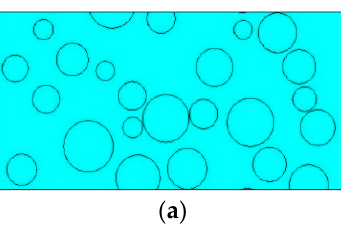
Figure 5. ( a ) Geometric model; ( b ) Meshing.